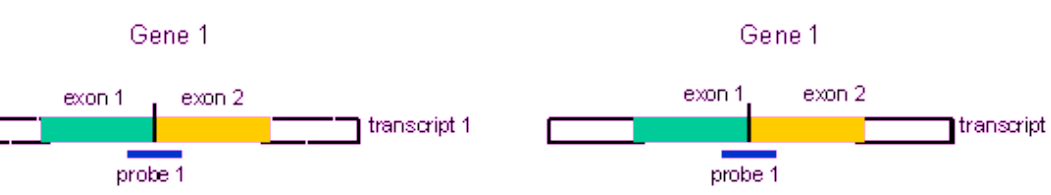
Figure 3: An example of a probe considered to be mapping uniquely to an exon-exon junction. Probe 1 maps to two exon-exon junctions that contain the same exons from di ff erent transcripts of the same gene (Gene 1). The exons of both transcripts are the same in terms of length and genomic position, i.e. the probe is mapping to the same genomic